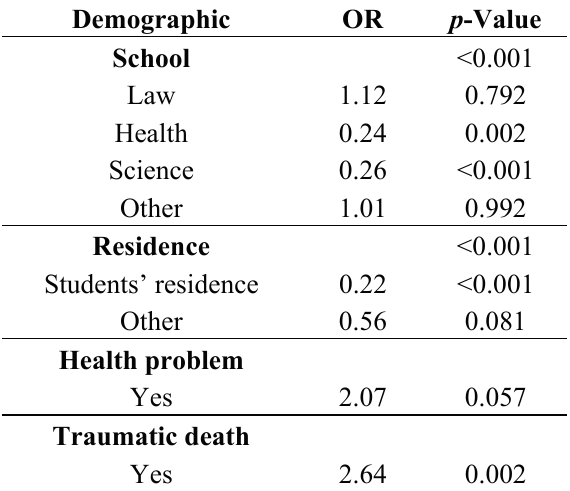
Table 10. Logistic regression coefficients for Beck Depression Inventory